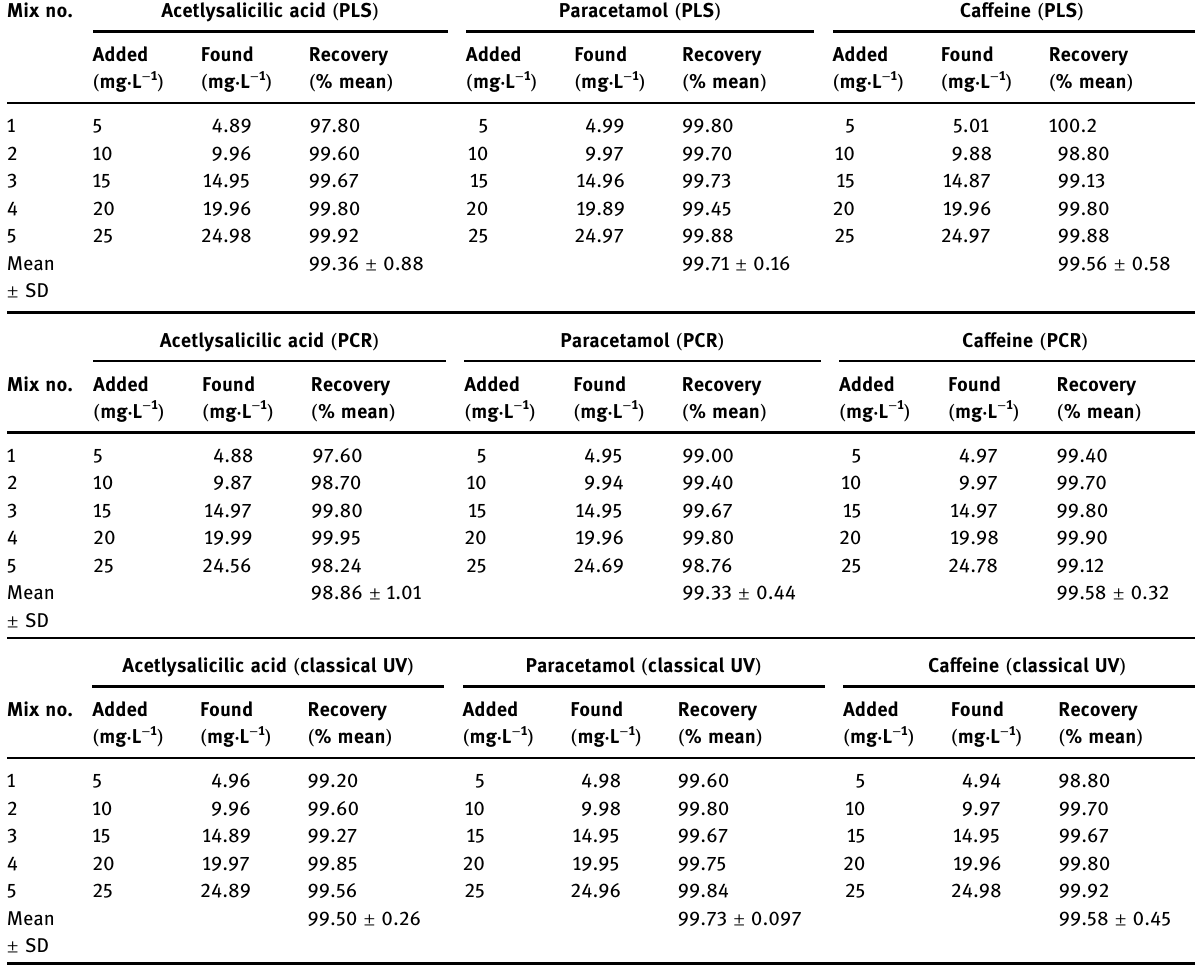
Table 6: Determination of ASA, PCM, CAF in human urine using PLS and PCR methods Mix